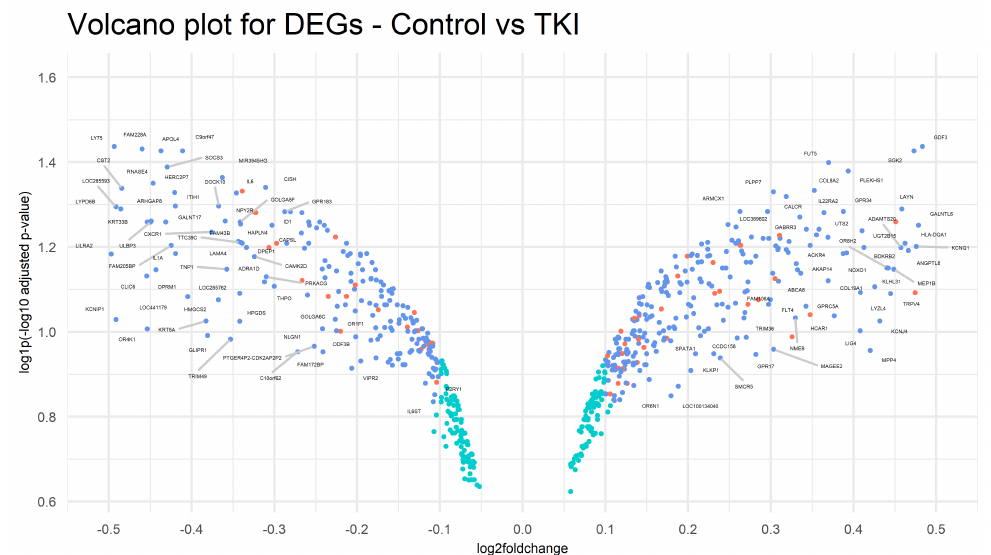
Figure 16. Volcano plot plot for DEGs. Genes are represented as scattered points: the x -axis is the log2FoldChange, and the y -axis shows the log1p( − log10 adjusted p -value). Both red and blue dots represent genes that were identified as significantly differentially expressed (adjusted p -value < 0.05) with | log2FoldChange | > 0.1. Specifically, red dots refer to transcription factors.